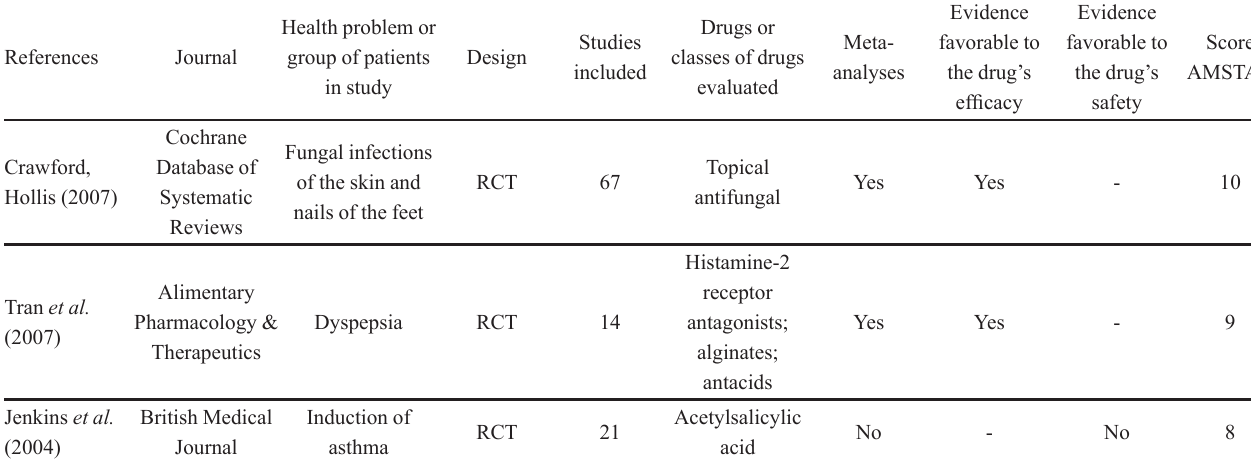
TABLE I - Main characteristics of systematic reviews on OTC drugs